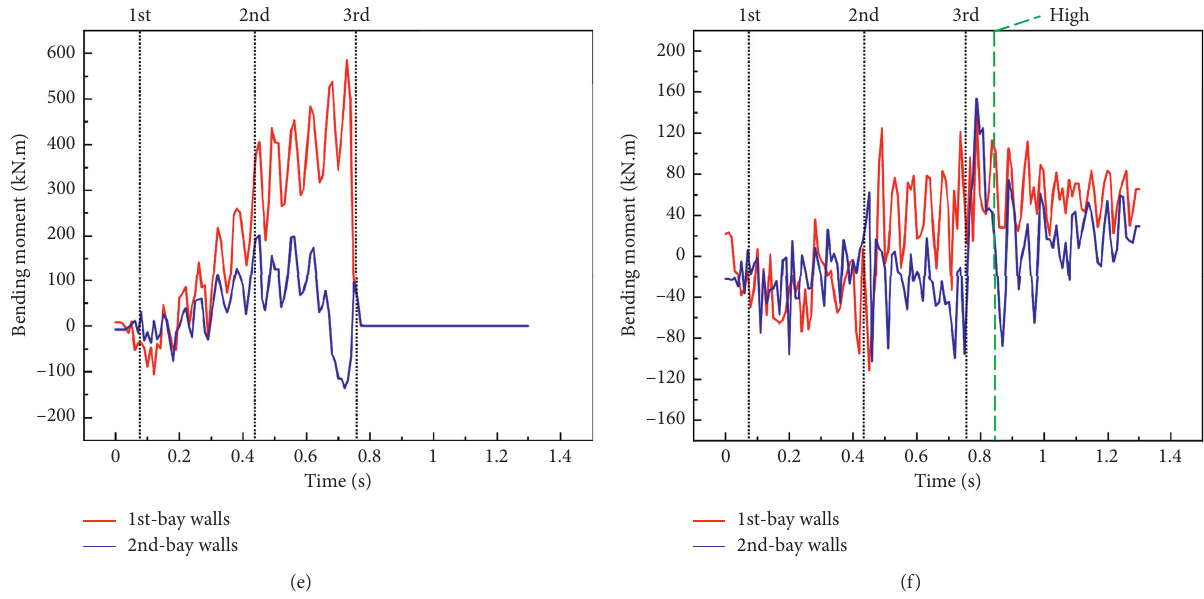
Figure 12: Time evolutions of: (a, b) vertical force, (c, d) shear force, and (e, f) bending moment at the bottom of longitudinal walls in the scenario of h � 3.2 m, v � 12.0m/s, s � 0 (a, c, e), and s � 1 (b, d,